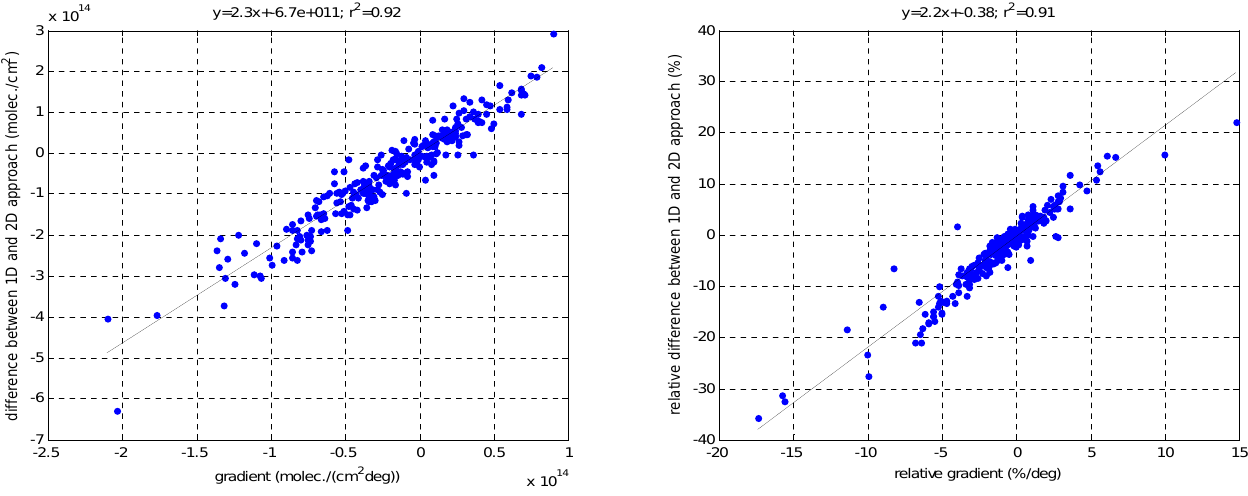
Fig. 10. Scatter plot between the gradient in the stratospheric NO 2 columns between 15 and 40km as observed for the 2-D retrieval (between two consecutive scanning sequences) and the difference between the NO 2 columns retrieved by the 1-D and 2-D approach. On the left panel: scatter plots between absolute values, on the right: the same for relative values (normalized by the vertical column acquired by the 2-D retrieval). Also shown are the lines of the best fit to the observed differences. Equations for the lines of the best fit and squared correlation coefficients r 2 are provided in the titles.